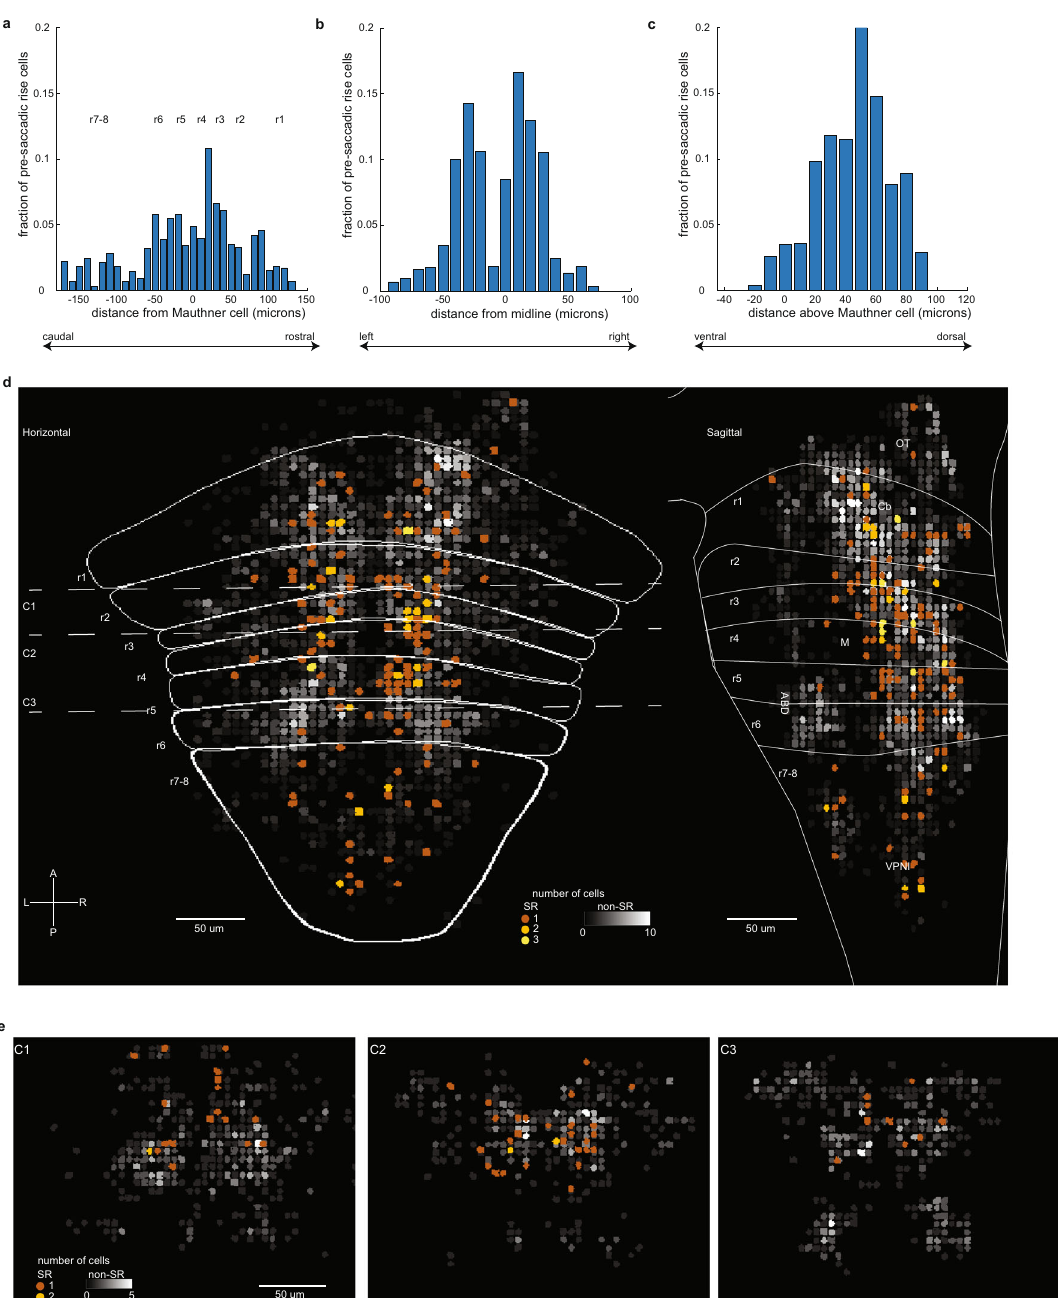
Fig. 6 Spatial distribution of SR cells. Histograms showing fraction of SR neurons as a function of their registered location onto a common reference brain for the rostral – caudal ( a ), left – right ( b ), and dorsal – ventral ( c ) directions. Fractions are weighted to account for unequal numbers of fi sh used to sample different hindbrain regions. Bin size is 10 µ m for a – c . Source data are provided in a Source data fi le. d Horizontal and sagittal projections showing the number of SR cells ( n = 156 cells examined over 15 fi sh) and the number of eye-movement responsive cells that are not classi fi ed as SR (black-white color scheme, n = 2,945 cells examined over 18 fi sh). The number of cells displayed in each nonoverlapping, 5 µ m bin was determined after subsampling to account for variations in the number of fi sh sampled per region (see “ Methods ” ). r1 – 8 indicates approximate rhombomere location within the reference brain. OT optic tectum, Cb cerebellum, M Mauthner cell, VPNI velocity-to-position neural integrator, ABD abducens complex, L – R left – right, A – P anterior – posterior. e Coronal projections made within 30 µ m of the dashed lines in d marked C1, C2, and